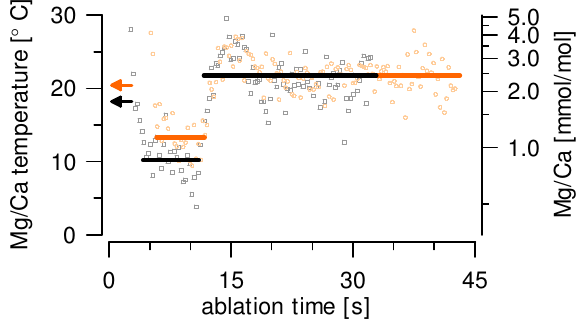
Fig. 9. Illustration of the influence of crust heterogeneity on temper- ature estimates. Calculated Mg/Ca-temperatures through the walls of two tests from the same sediment trap bottle (colours denote dif- ferent tests). Thick lines show average crust and inner layer values and arrows the whole wall mean. Mn/Ca profiles through the two tests are close to the detection limit, but appear